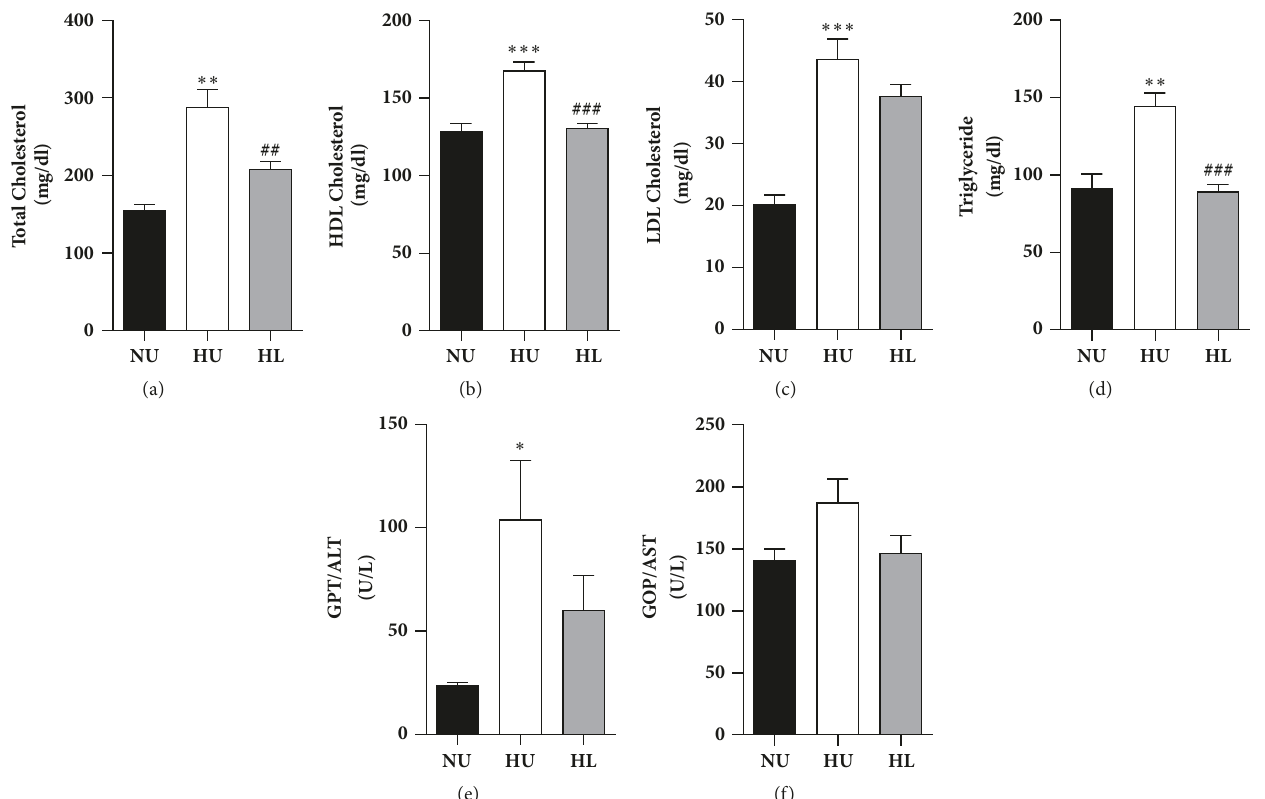
Figure 3: Lobeglitazone treatment reduces serum cholesterol and triglyceride (TG) levels in HFD-fed mice. Serum concentrations of lipid were measured after 12 weeks of a HFD or NCD. (a) Serum total cholesterol level. (b) Serum high density lipoprotein (HDL) cholesterol level. (c) Serum low density lipoprotein (LDL) cholesterol level. (d) Serum TG level. (e) Alanine aminotransferase (ALT) level. (f) Aspartate aminotransferase (ALP) level. NU: normal chow diet- (NCD-) fed mice without treatment (NU, black bar), HU: HFD-fed mice without treatment (white bar), and HL: HFD-fed mice with lobeglitazone treatment (gray bar). Data are expressed as means ± SEM. ∗ p < 0.05, ∗∗ p < 0.001, and ∗∗∗ p < 0.0001, NU versus. HU group. # p < 0.05, ## p < 0.001, and ### p < 0.0001, HL versus. HU